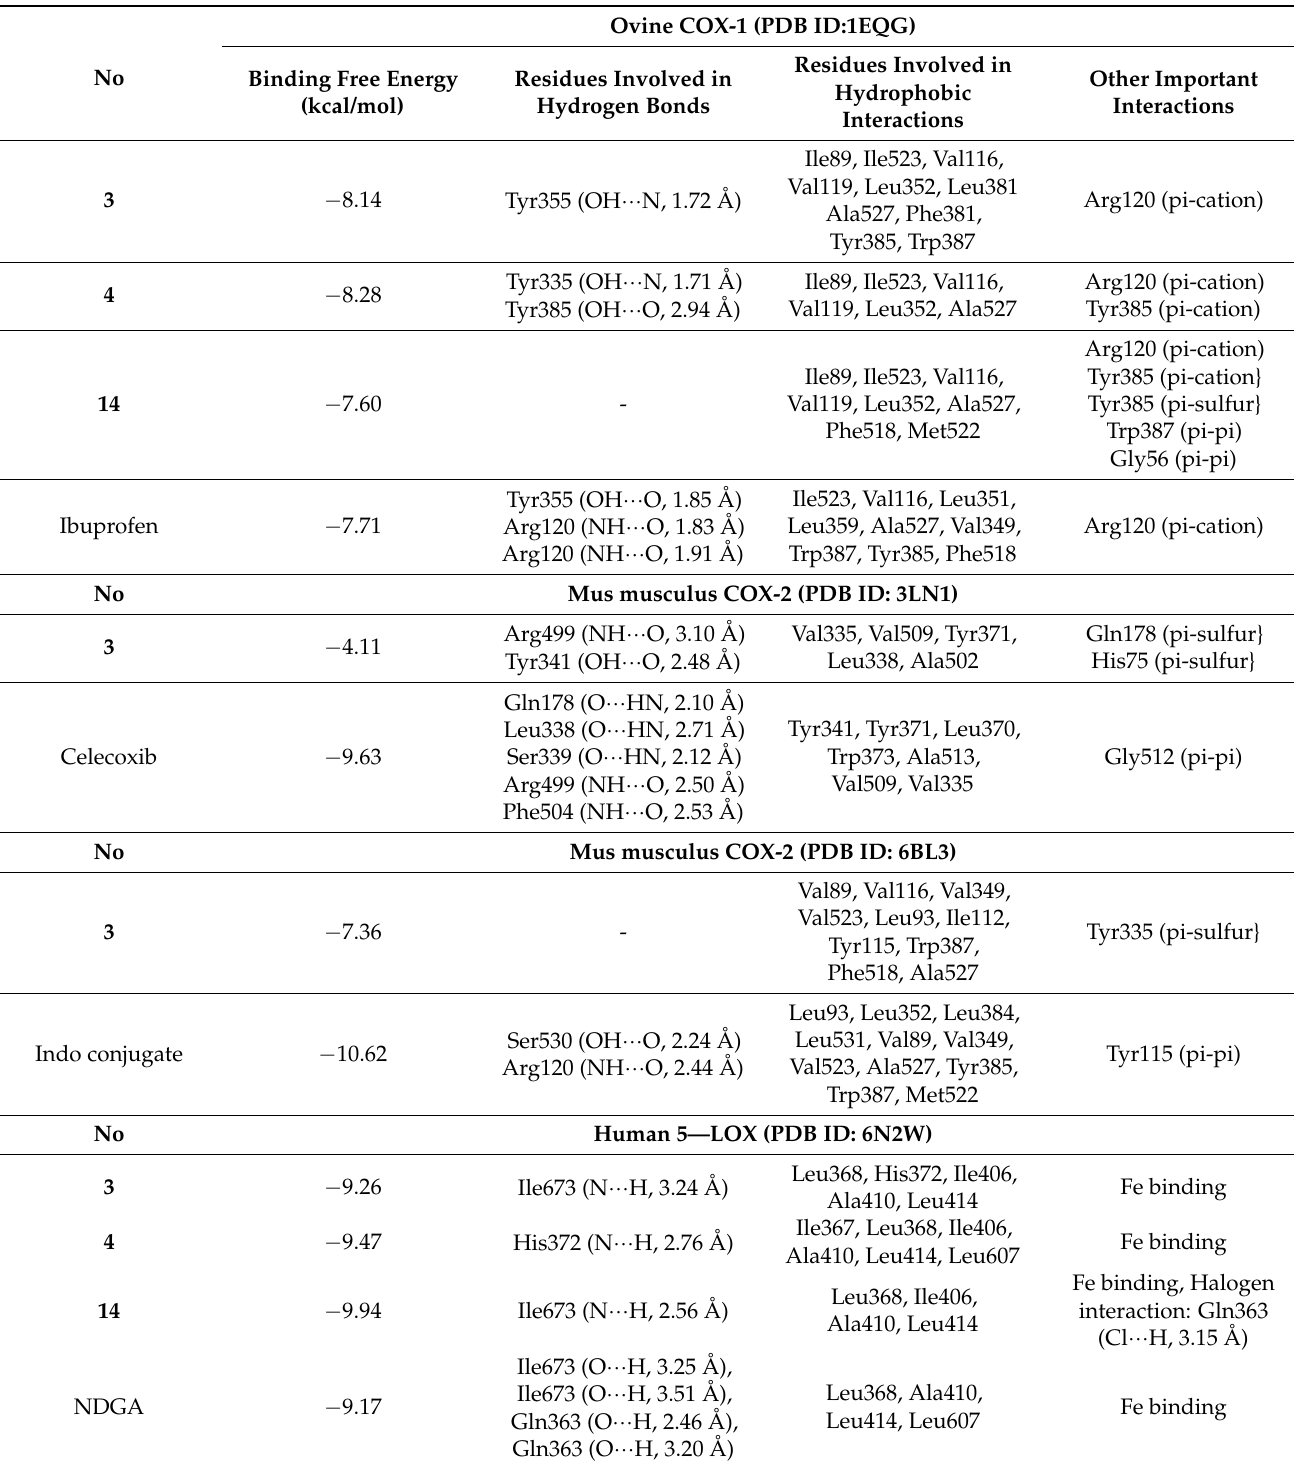
Table 4. Docking studies of derivatives in COX-1/-2 and 5-LOX crystal